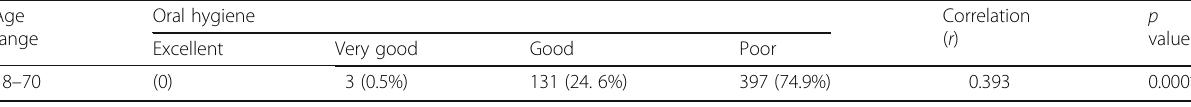
Table 1 Correlation between oral health status and the age of the surveyed sample Age